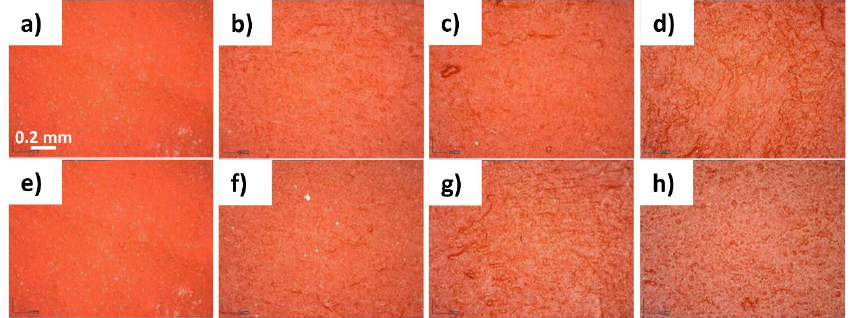
Figure 2. Images of untreated red painted surfaces ( a , e ); surfaces treated with PRO-ART with ( b ) 1 application, ( c ) 2 applications, and ( d ) 3 applications; and surfaces treated with AG09W with ( f ) 1 application, ( g ) 2 applications, and ( h ) 3 applications .